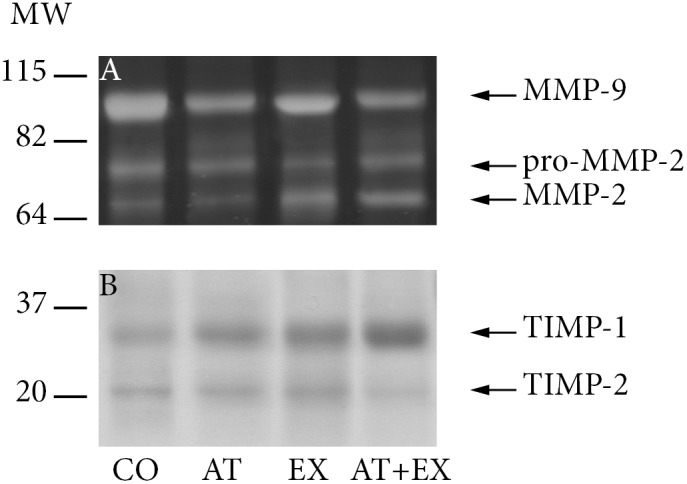
Representative images from zymograms for the identification of metalloproteinase activity and reverse zymograms for the identification of TIMP activity.A) Zymograhy, MMP-2, MMP-9 and proMMP-2 identification. B) Reverse zymography, TIMP-1 and TIMP-2 identification.